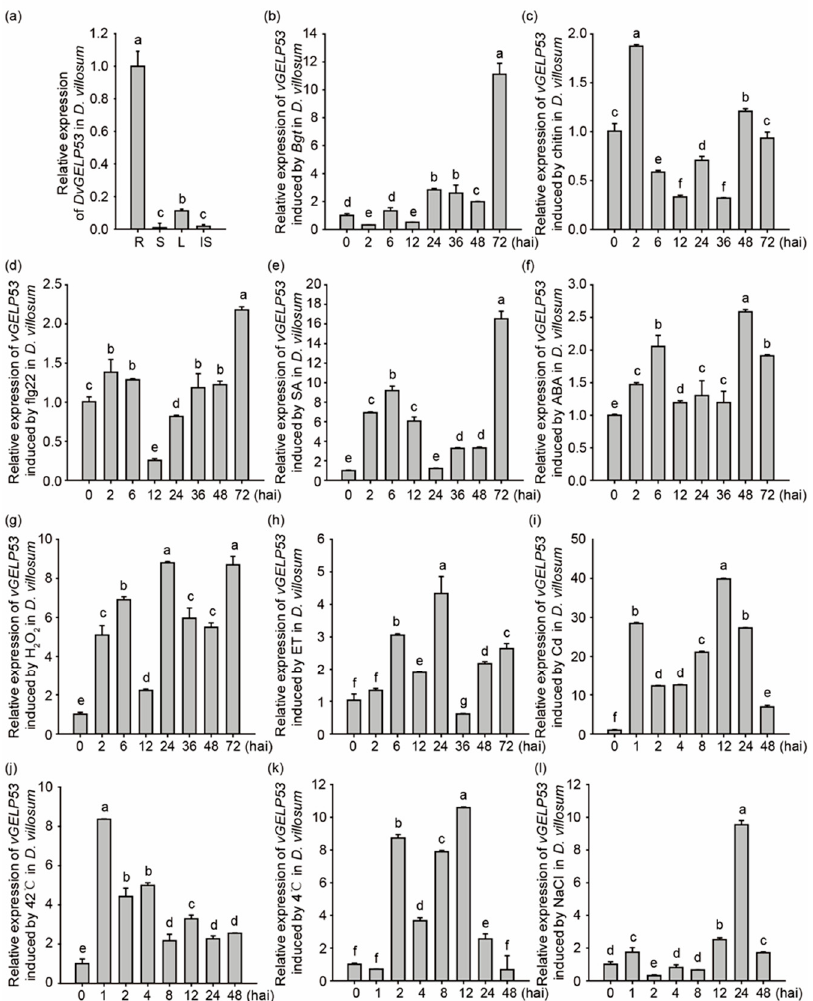
Figure 6. Expression profiling of DvGELP53 . ( a ) The expression of DvGELP53 in the root (R), the stem (S), the leaf (L) and the immature spike (IS) of D. villosum . The expression in the root is set to 1. Time course expression profiling of DvGELP53 in the leaf of D. villosum in response to Bgt ( b ), chitin ( c ), flg22 ( d ), SA ( e ), ABA ( f ), H 2 O 2 ( g ), ET ( h ), Cd ( i ), 42 °C ( j ), 4 °C ( k ) and NaCl ( l ). The expression at 0 h is set as 1. Bars indicate the standard error (SE), bars with different letters show significant differences at p < 0.05.